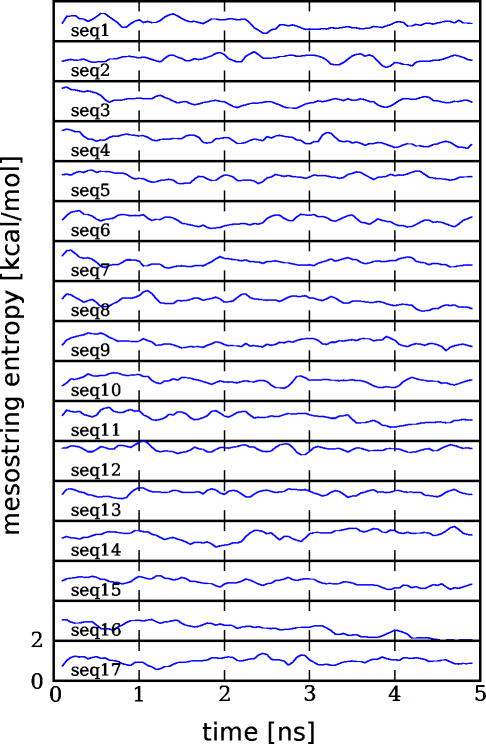
Variation of the Information Entropy of Mesostrings in the 17 Peptides from Protein GThe entropy at each point is calculated over a 0.2-ns window. The backbone entropy holds fairly steady after 1 ns.